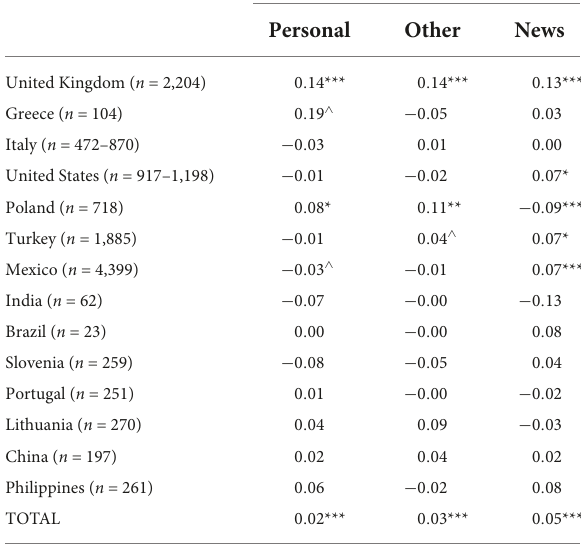
TABLE 6 The relationship of biological sex with COVID experiences across nations. Nation Measure Personal Other